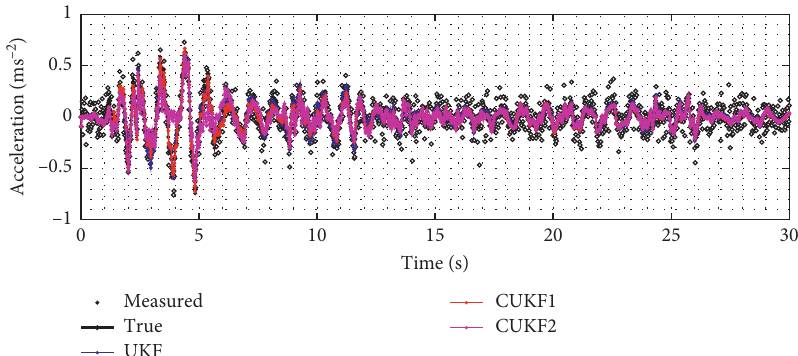
Figure 4: Comparison of acceleration time history results for Example 2 identified by the UKF, CUKF1, and